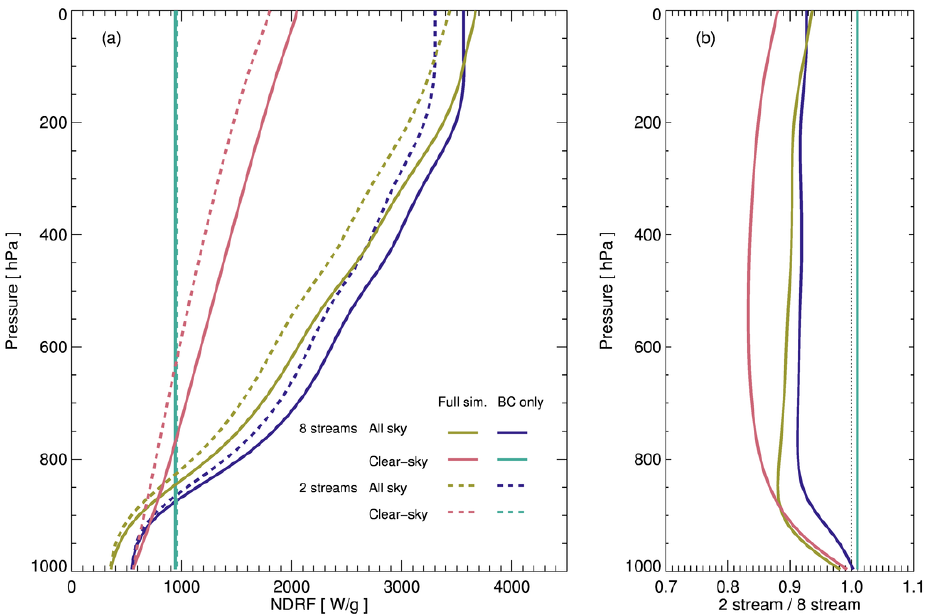
Figure 2. (a) BC RF normalized by abundance, as a function of altitude. Solid lines: eight-stream simulations. Dashed lines: two-stream simulations. Colours represent all sky and clear sky conditions, and whether a full atmospheric simulation including Rayleigh scattering, water vapour and background aerosols was performed (“Full sim”), or if BC was the only radiatively active agent (“BC only”); (b) ratio of two-stream to eight-stream simulation results, for the four cases shown in (a)